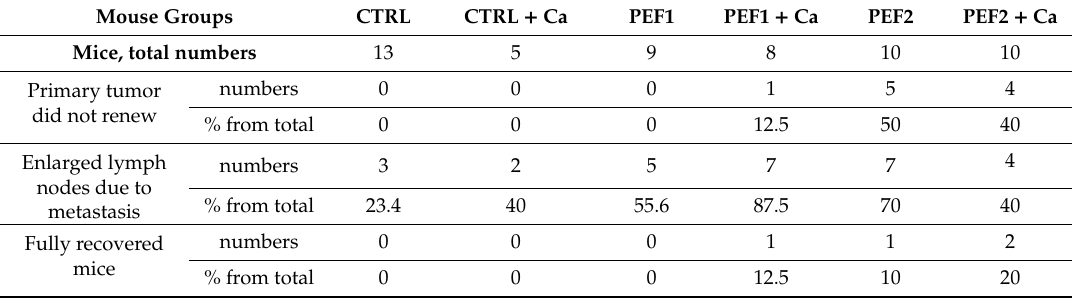
Table 1. Metastasis of SP2 / 0 Luc cells after electroporation of the